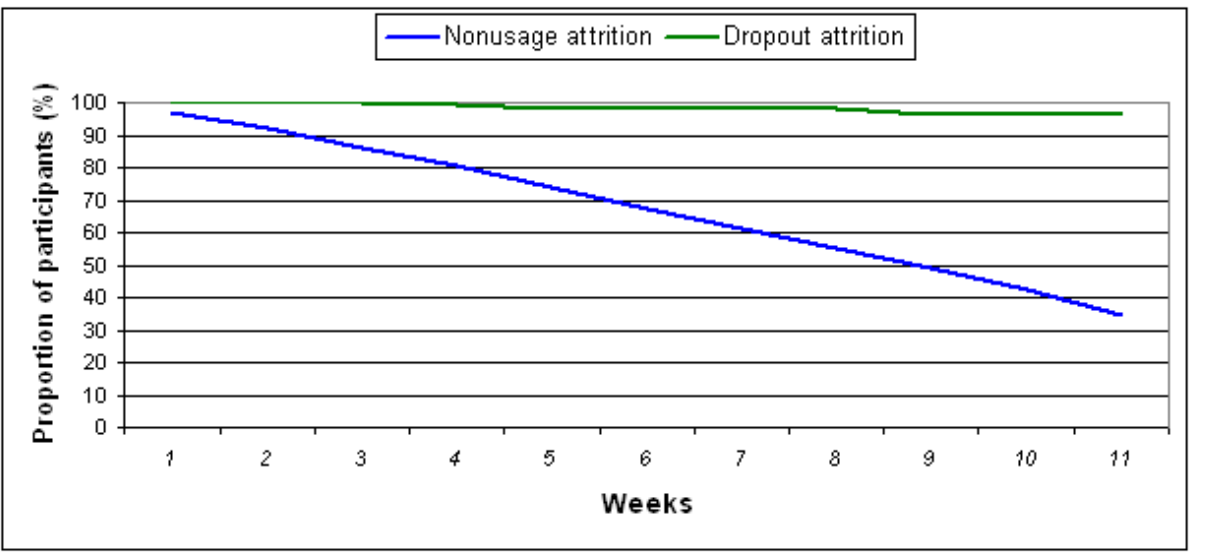
Figure 4. Dropout attrition and nonusage attrition from enrollment to 12 weeks among 12 week